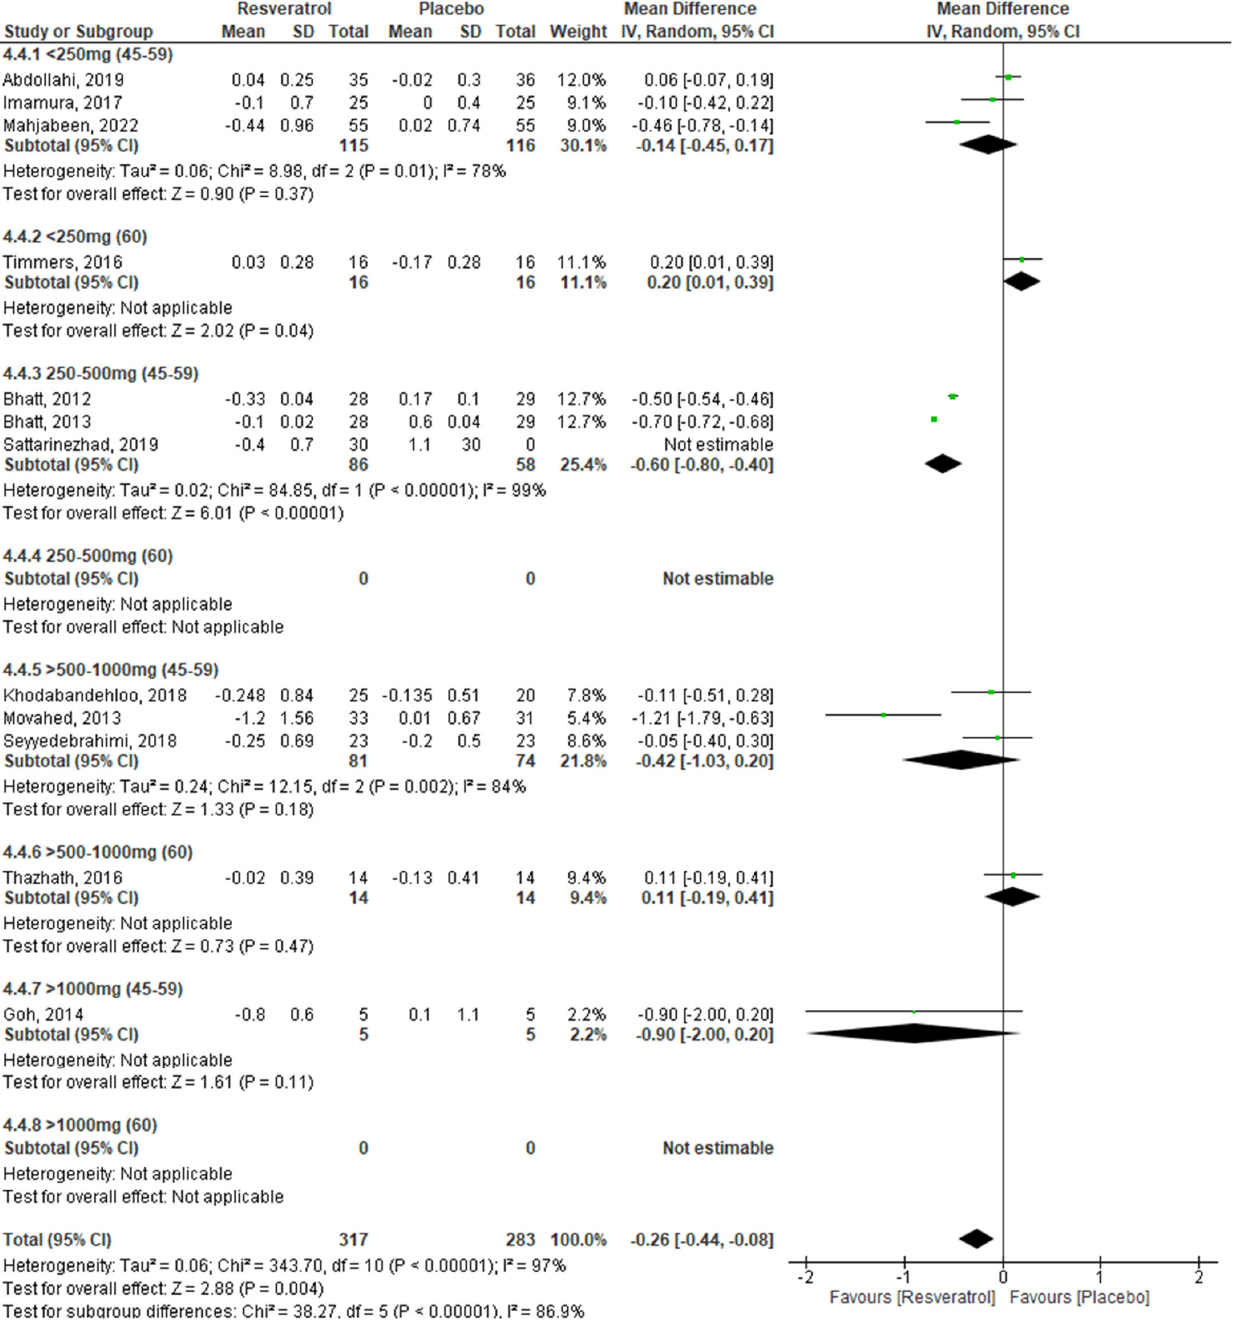
Figure 4. Effect of RV on HbA1c, stratified by age and dose.